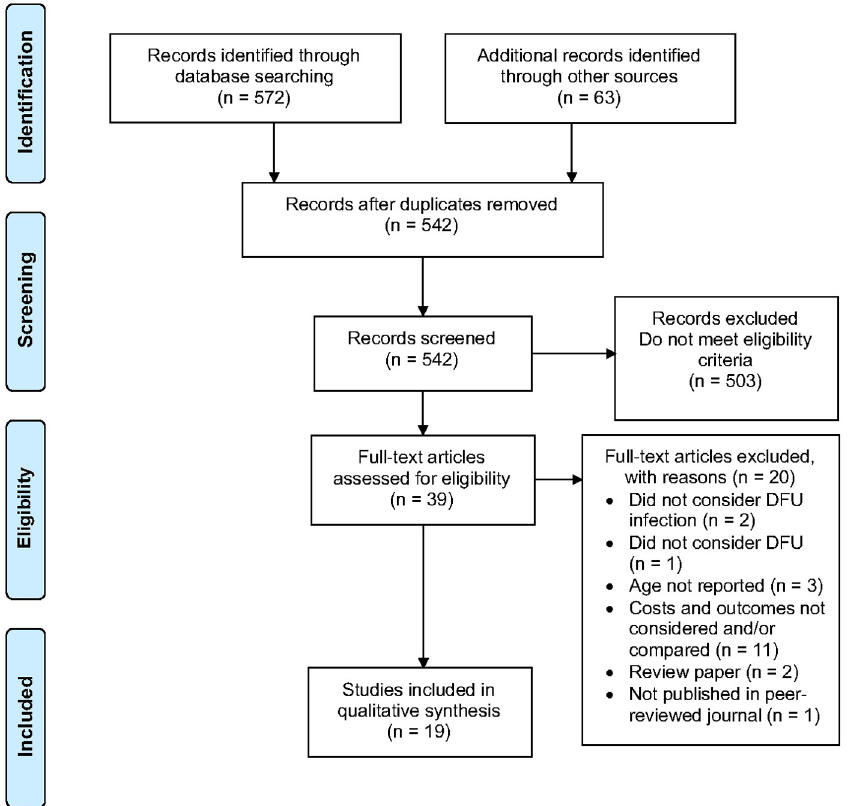
Fig 1. Preferred Reporting Items of Systematic Reviews and Meta-Analyses (PRISMA) flow diagram showing study selection process. DFU: diabetic foot ulcer.